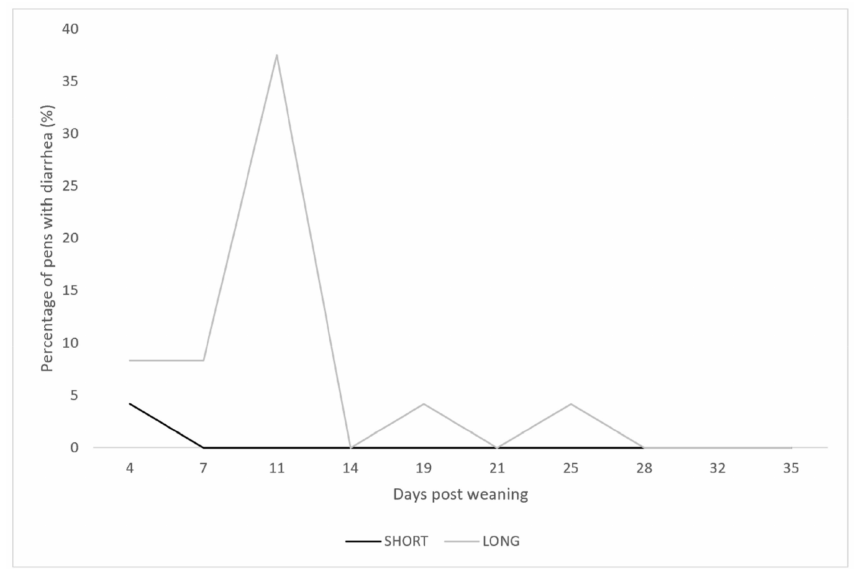
Figure 4. Percentage of pens with diarrhoea for SHORT (black, 8 h light and 16 h dark) compared to LONG photoperiod piglets (grey, 16 h light and 8 h